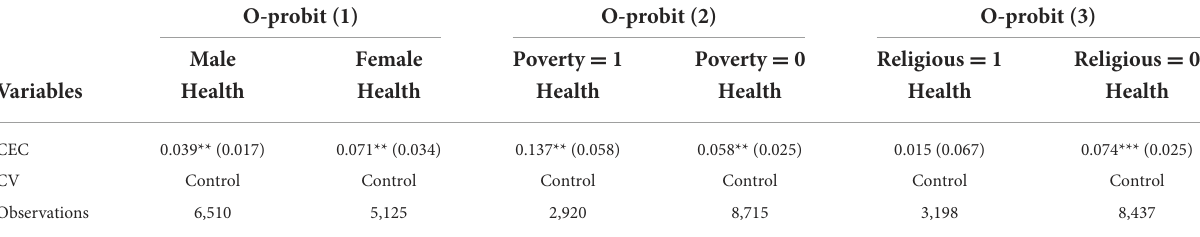
TABLE 6 The results of heterogeneity analysis of CEC and